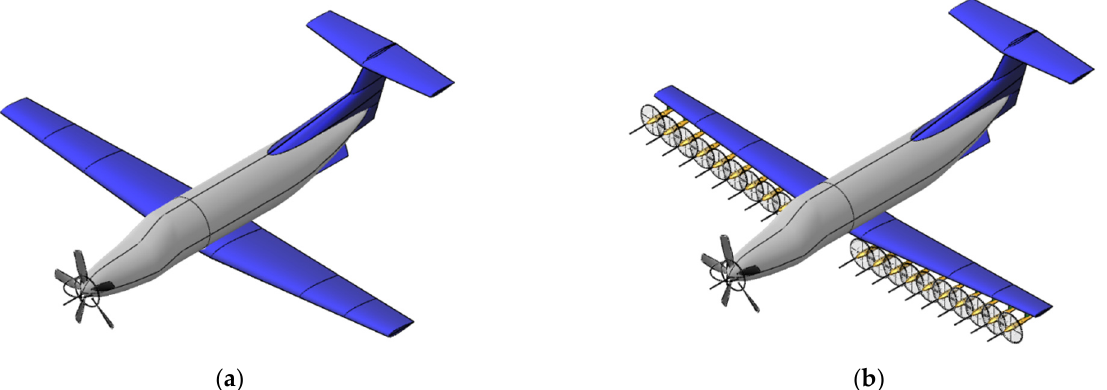
Figure 14. Geometrical drawing of the original aircraft configuration ( a ) and aircraft with wing with 65% area and DEP system in landing configuration ( b )